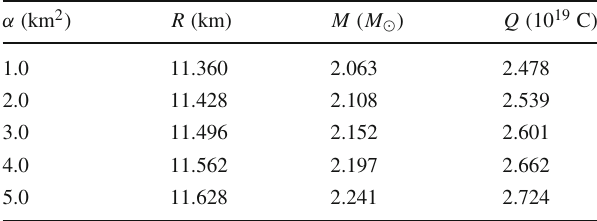
Table 2 Properties of charged quark stars with central mass density ρ = 1 . 5 × 10 18 kg / m 3 and EoS (23) in 4 D EGB gravity for β = 0 . 2 c and different values of the GB coupling